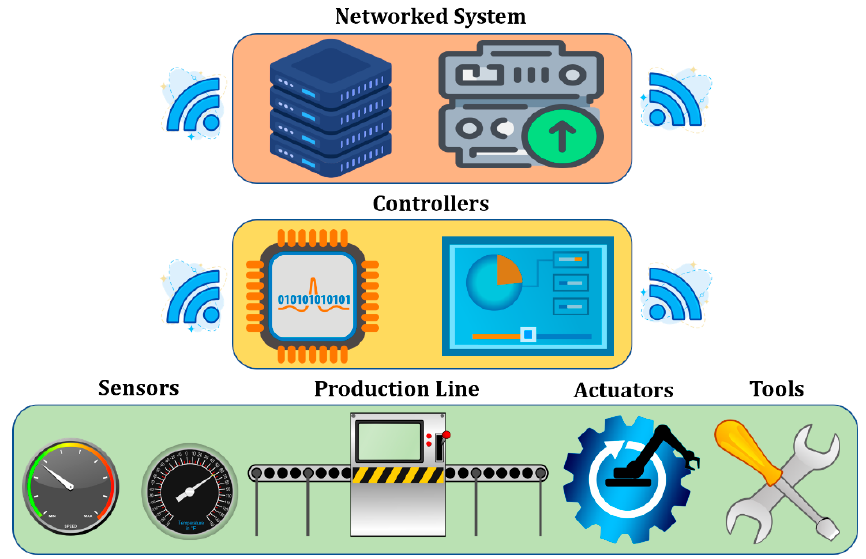
Figure 8. Manufacturing process in today’s factories.